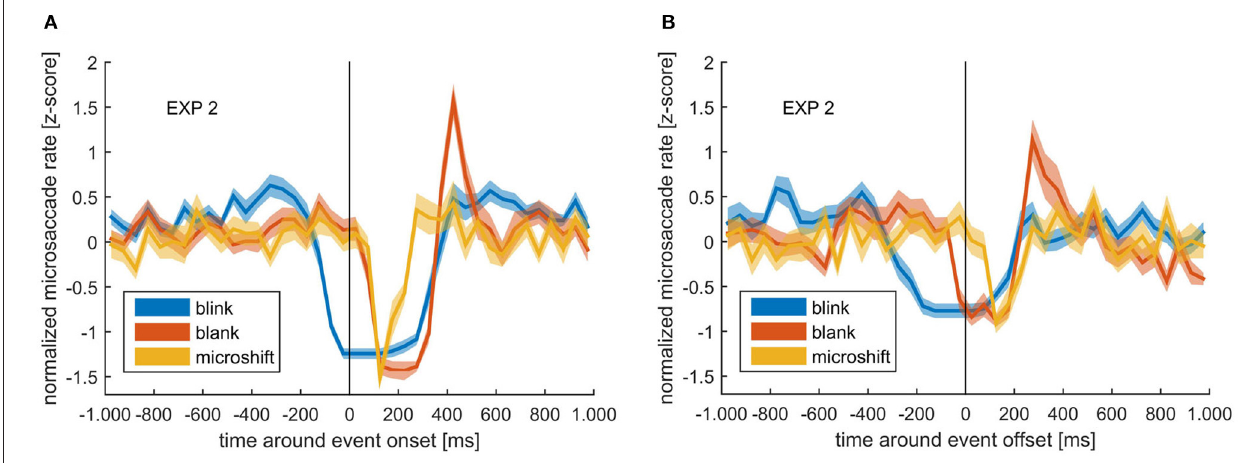
FIGURE 6 | (A) Normalized microsaccade rate around blink onset (blue), blank onset (red), and microshift (yellow). (B) Normalized microsaccade rate around blink offset (blue), blank offset (red), and microshift (yellow). Colored lines and ribbons represent mean ±